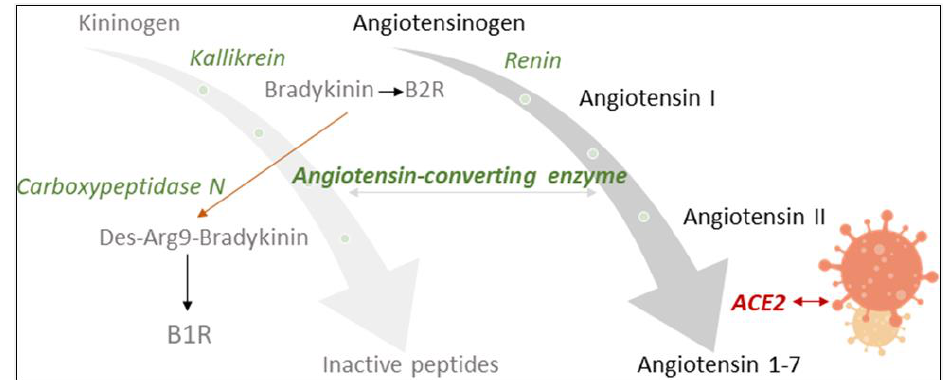
Figure 1. Influence of SARS-CoV2-infection on the renin–angiotensin system (RAS) and the kinin– kallikrein system, which are linked by angiotensin-converting enzyme (ACE). ACE2 counter-balances the RAS by inactivating angiotensin II. Being a functional receptor of SARS-CoV2, ACE2 availability decreases upon infection. ACE activity may subsequently increase with an impact on the cleavage of bradykinin (BK). Carboxypeptidase N (CPN) also degrades BK, changing receptor specificity from the B2 to the B1 receptor. ACE and CPN activity were measured in this study with a specially designed neuropeptide reporter assay [11].